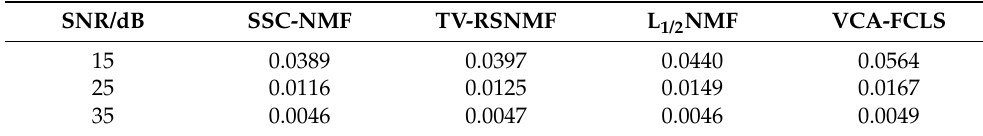
Table 3. RMSE values of different methods with the simulated data. SNR/dB SSC-NMF L 1/2